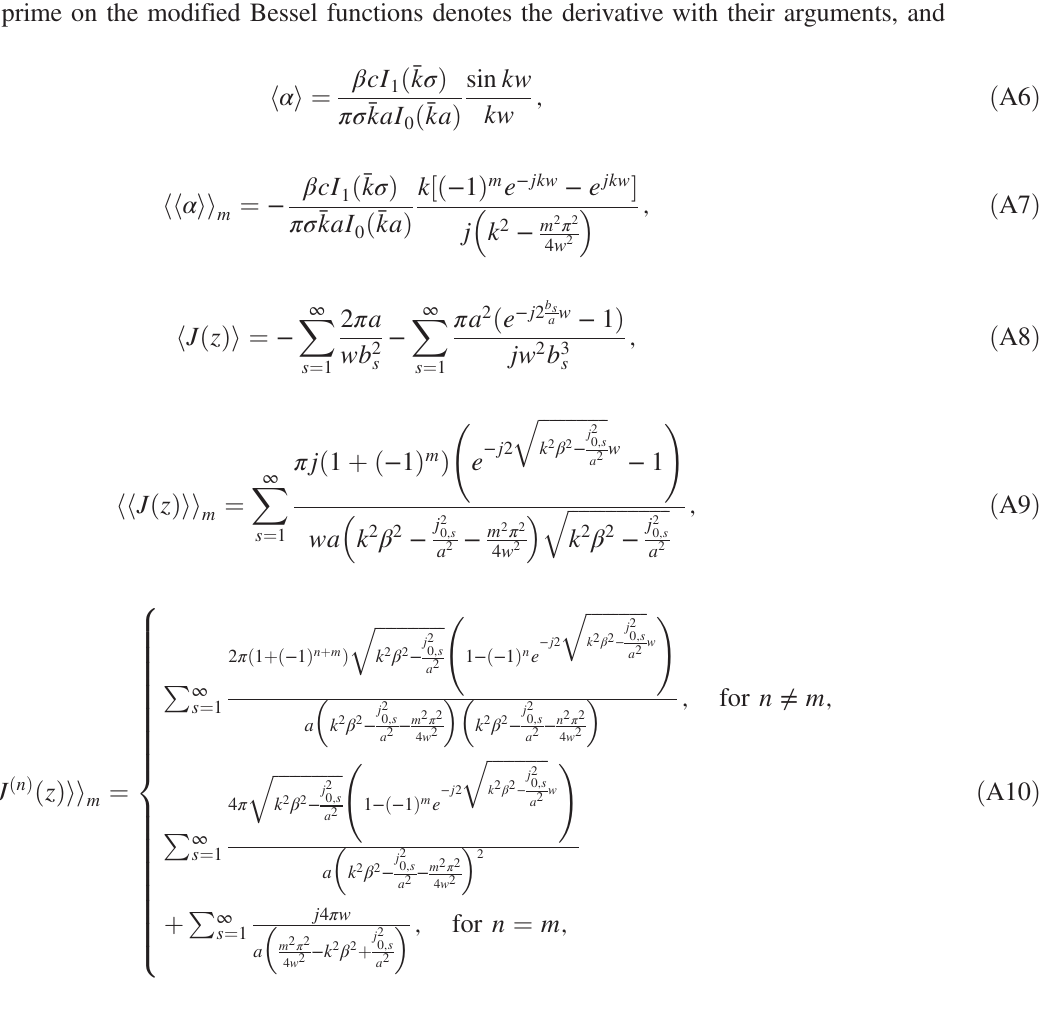
ffiffiffiffiffiffiffiffiffiffiffiffiffi